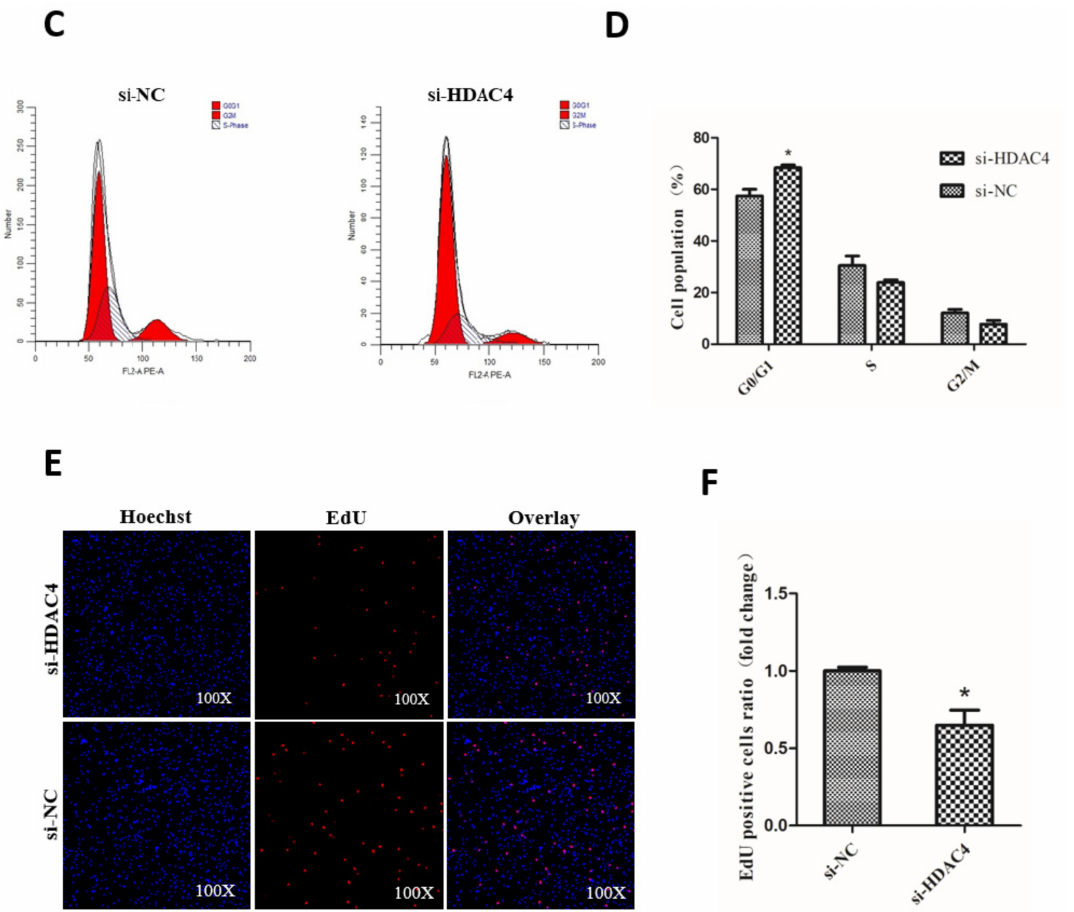
Figure 3. Knockdown of HDAC4 inhibits the proliferation of chicken SMSCs. ( A ) The expression level of cyclinD1, cyclinD2, Ki67, and PCNA was determined by qPCR in SMSCs after being transfected with si-HDAC4 and si-NC. ( B ) The proliferation activity of SMSCs after transfection with si-HDAC4 and si-NC was evaluated by CCK-8 at 12 h, 24 h, 36 h, and 48 h. ( C , D ) Flow cytometry for cell cycle analysis of SMSCs at 48 h after transfection of si-HDAC4 and si-NC. ( E ) EdU assays for SMSCs transfected with si-HDAC4 and si-NC for 36 h. EdU (red) fluorescence indicates proliferation. Hoechst (blue) fluorescence indicates nuclei. All photomicrographs are at 100 × magnification. ( F ) The percentage of EdU stained cells to total cells was calculated at 36 h after transfection of si-HDAC4 and si-NC. In all panels, the values represent mean ± SEM from three independent experiments. * p < 0.05; ** p <